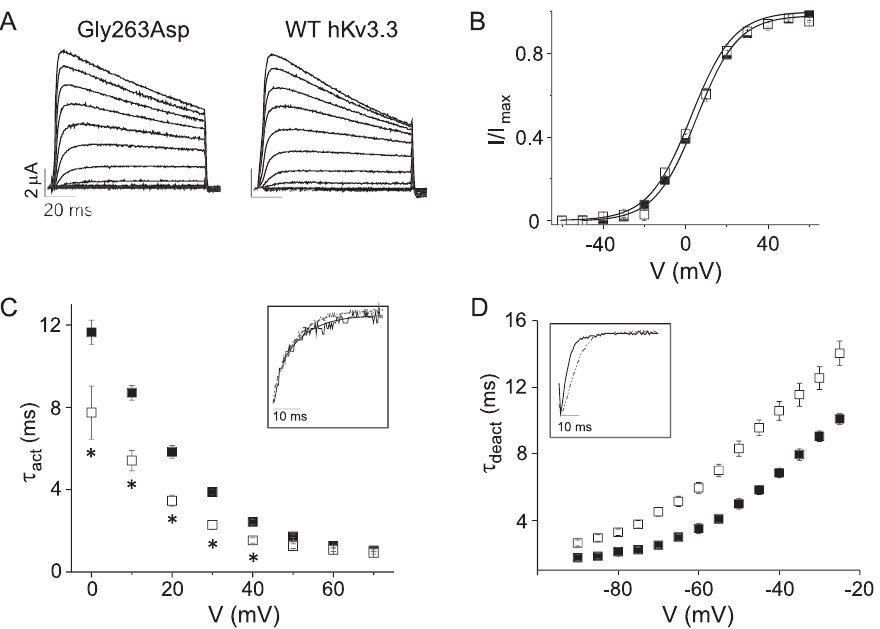
Figure 3. Mutation kinetics in X.laevis oocytes. p.Gly263Asp alters activation and deactivation kinetics in X. laevis oocytes. ( A ) p.Gly263Asp currents were evoked by stepping from 2 90 mV to voltages ranging from 2 90 mV to + 70 mV in 10 mV increments. ( B ) Normalized isochronal tail current amplitudes have been plotted versus voltage for wild-type ( & , n =84) and p.Gly263Asp ( % , n =8). ( C ) Activation time constant ( t act ) was plotted versus voltage. *Wild-type ( & , n =36) and p.Gly263Asp ( % , n =8) values differed significantly , p , 0.05. Inset: Wild-type (solid) and p.Gly263Asp (dotted) currents were evoked at 0 mV, scaled and overlaid. ( D ) Deactivation time constant ( t deact ) was plotted versus repolarization voltage. Wild-type ( & , n =10) and p.Gly263Asp ( % , n =8) values differed significantly, p , 0.05. Inset: Wild-type (solid) and p.Gly263Asp (dotted) tail currents were recorded at 2 60 mV, scaled and overlaid.